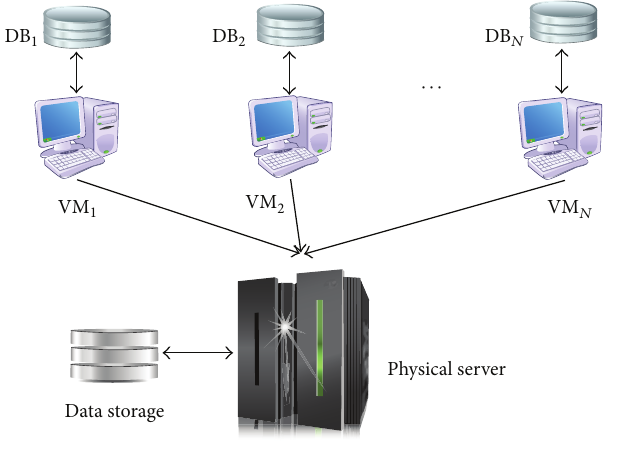
Figure 1: Virtualization of resources on a server.